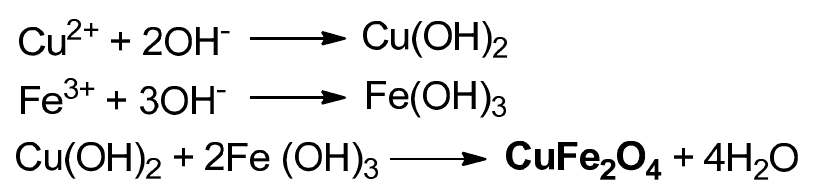
Scheme 15. Chemical reaction of Spinel maghemite-copper nanoparticles.